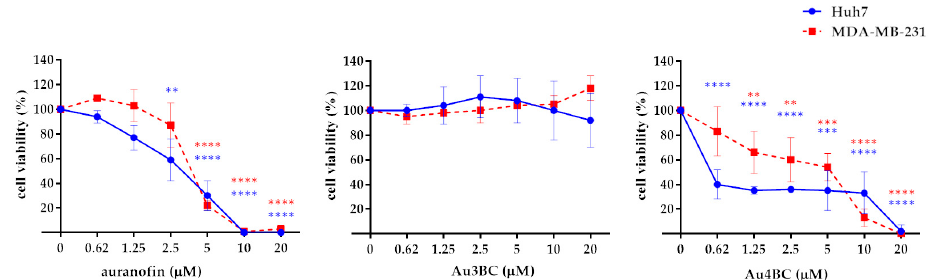
Figure 4. Effects of Au3BC and Au4BC treatment on cell viability in HCC and BC cell lines. Huh7 and MDA-MB-231 cells were treated with different concentrations of auranofin, Au3BC, and Au4BC for 72 h. Cell viability was determined by using an MTS assay. Auranofin was used as the positive control inhibitor for TrxR1. Data are expressed as the percentage of control cells and are the means ± SD of three separate experiments, each performed in triplicate. ** p < 0.01, *** p < 0.005, **** p < 0.001.